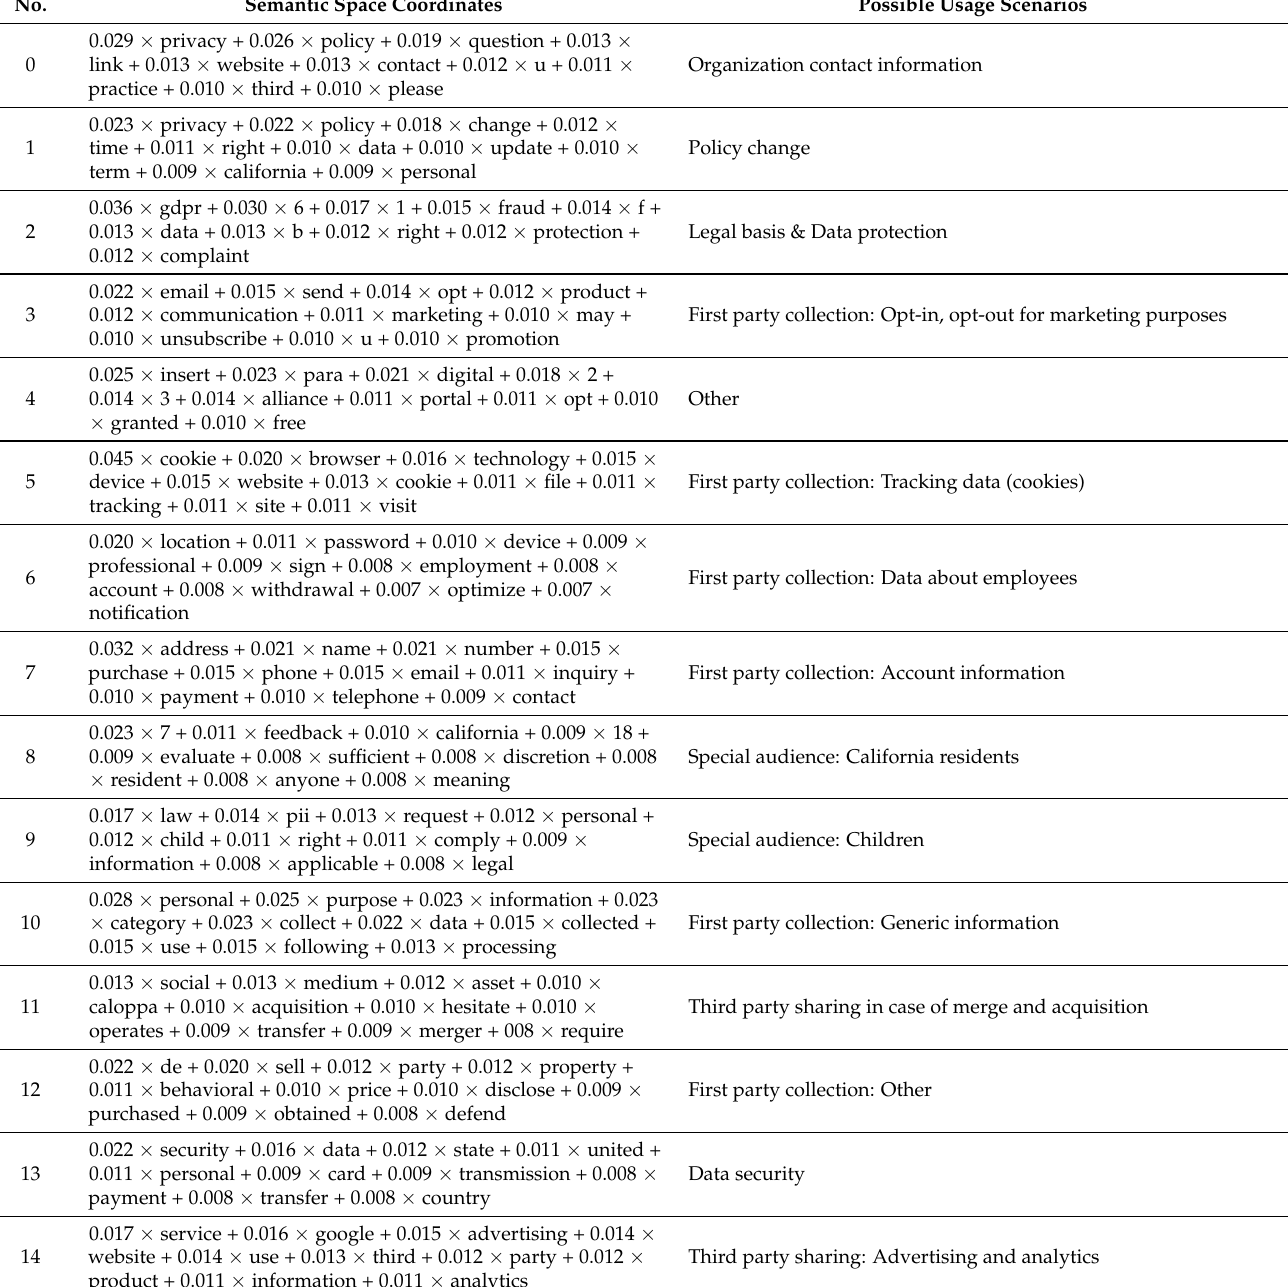
Table 2. Results of topic modeling for the IoT